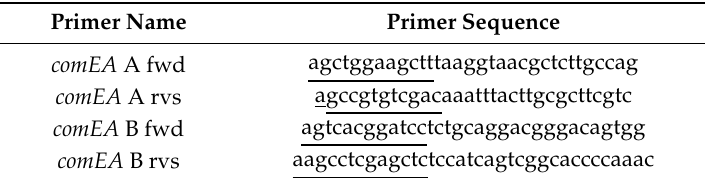
Table 2. Primers used in this